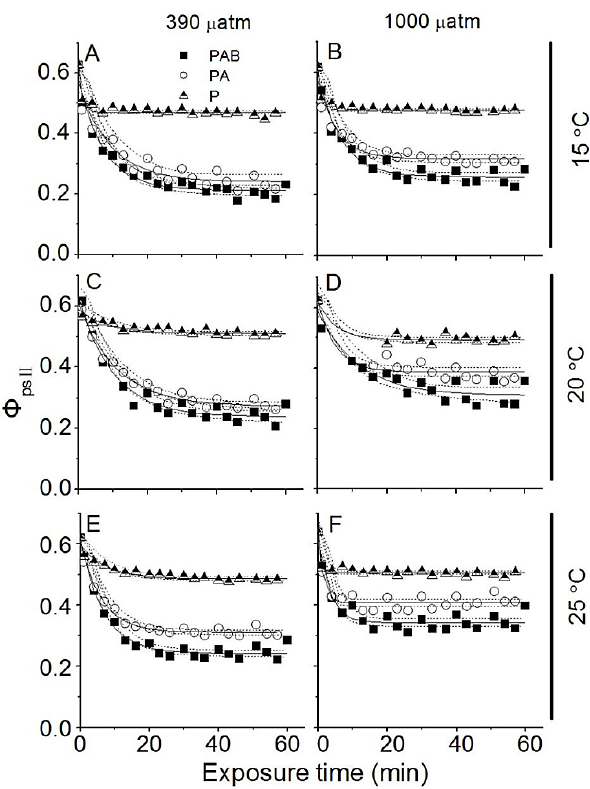
Fig. 1. Changes in effective photochemical quantum yield ( 8 PSII ) of P. tricornutum cells grown under ambient (390µatm, LC) ( A , C and E ) and elevated CO 2 (1000µatm, HC) partial pressures ( B , D and F ) when exposed to solar radiation for 60min under three radia- tion treatments – PAB (irradiated above 295nm, black squares), PA (irradiances above 320 nm, white circles) and P (irradiances above 395nm, half solid triangles) – at 15, 20 and 25 ◦ C. Solid lines repre- sent the best fit while the broken lines represent the 95% confident limits.